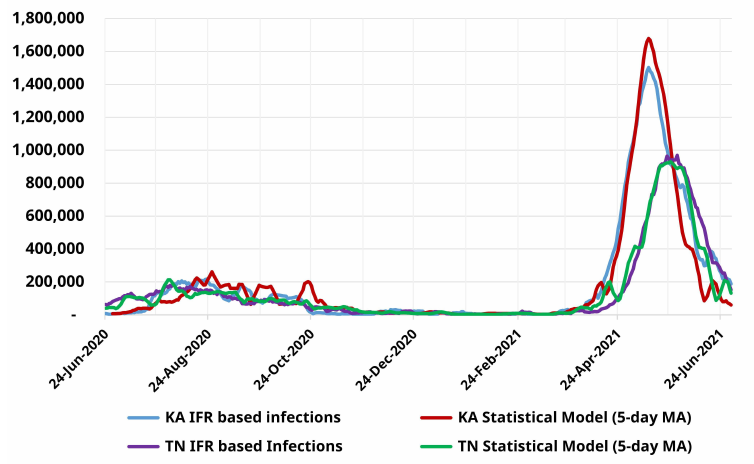
Figure 2. Comparison between the statistical model and IFR-based infection occurrence estimates for Tamil Nadu and Karnataka from 24-June-2020 to 30-June-2021.